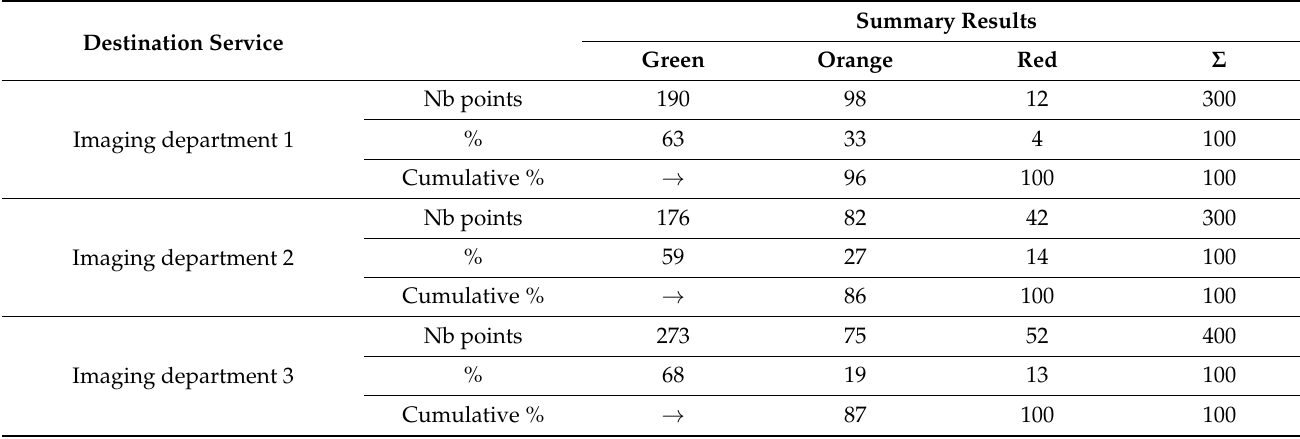
Table 2. Positioning determination accuracy.